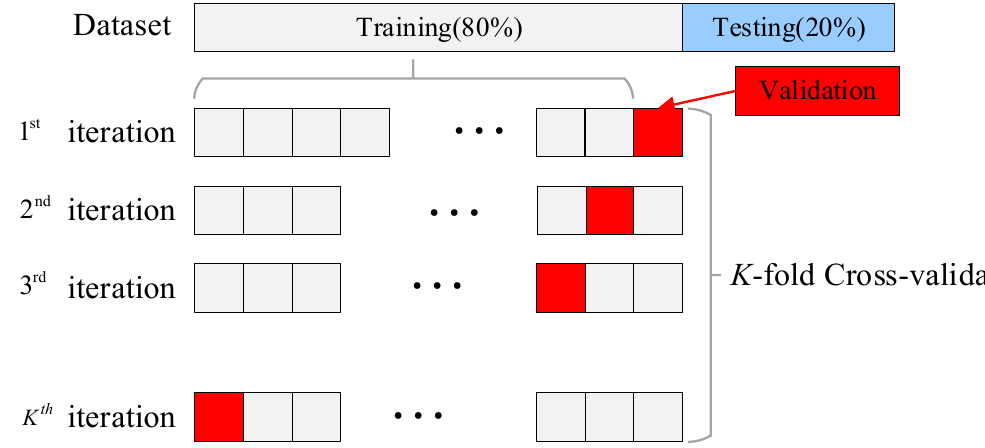
Figure 5. K- fold crossvalidation method.